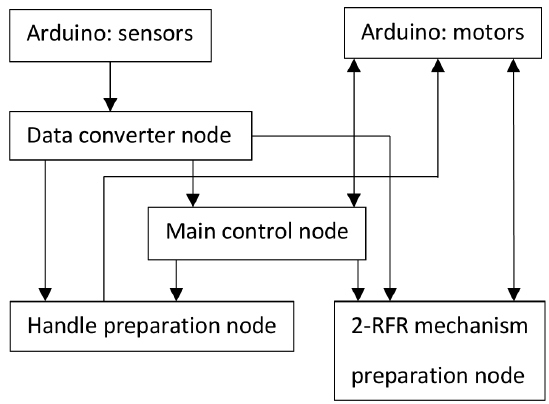
Figure 8. Flowchart of the ROS node structure: nodes in rectangles; topics as arrows.